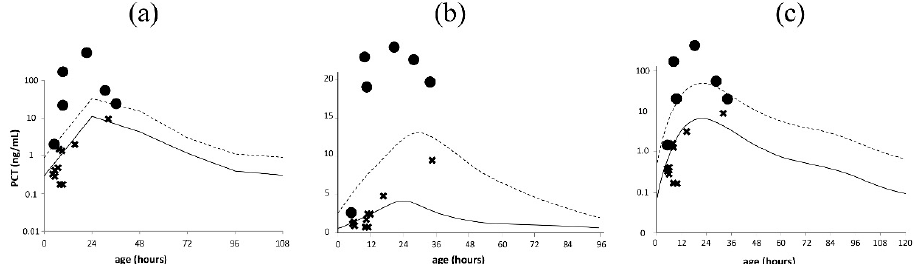
Figure 1. Serum PCT levels of preterm infants in the confirmed and non-infection groups. Serum PCT